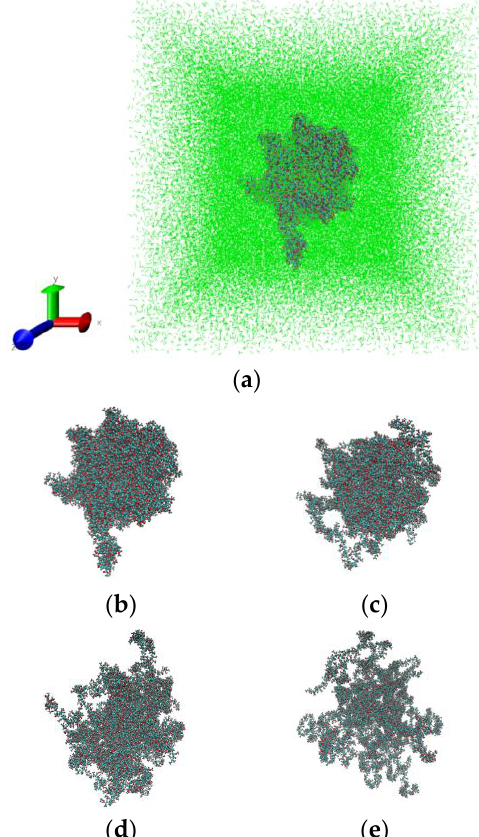
Figure 6. Snapshots of PMMA in sc-CO 2 (green) at 333 K and 25 MPa: 0 ns ( a , b ), 2 ns ( c ), 5 ns ( d ) and 10 ns ( e ). The solvent molecules have been deleted from figures ( b – e ) for clarity to highlight polymer